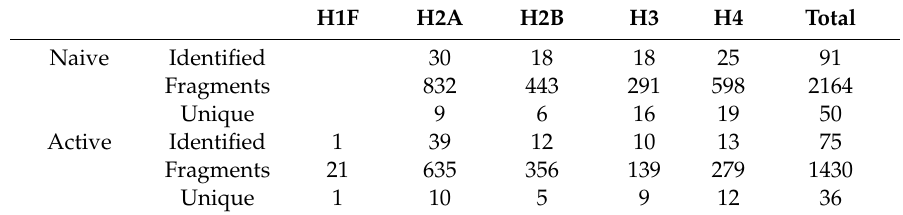
Table 1. Number of unique modified sequences identified from naïve and activated CD8 T cells. H1F H2A H2B